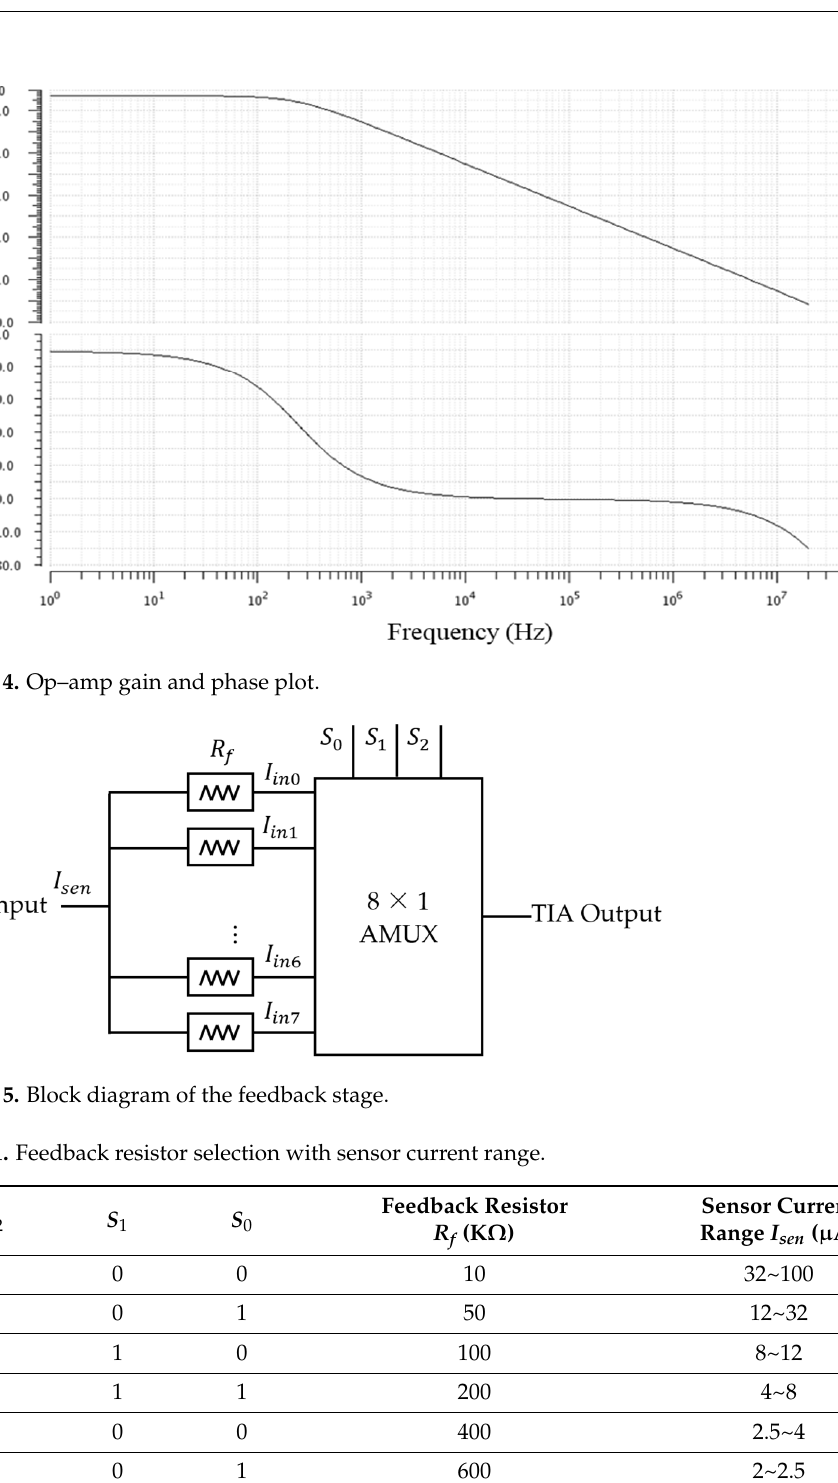
Figure 5. Block diagram of the feedback stage. Table 1. Feedback resistor selection with sensor current range.